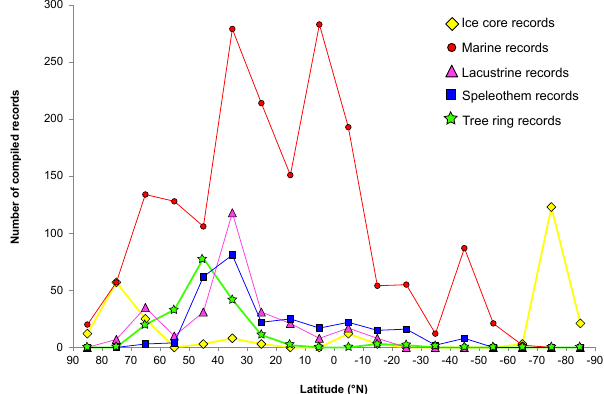
Figure 4. Diagram showing the distribution of ice core, tree-ring, lacustrine, speleothem and marine records as a function of latitude ( ◦